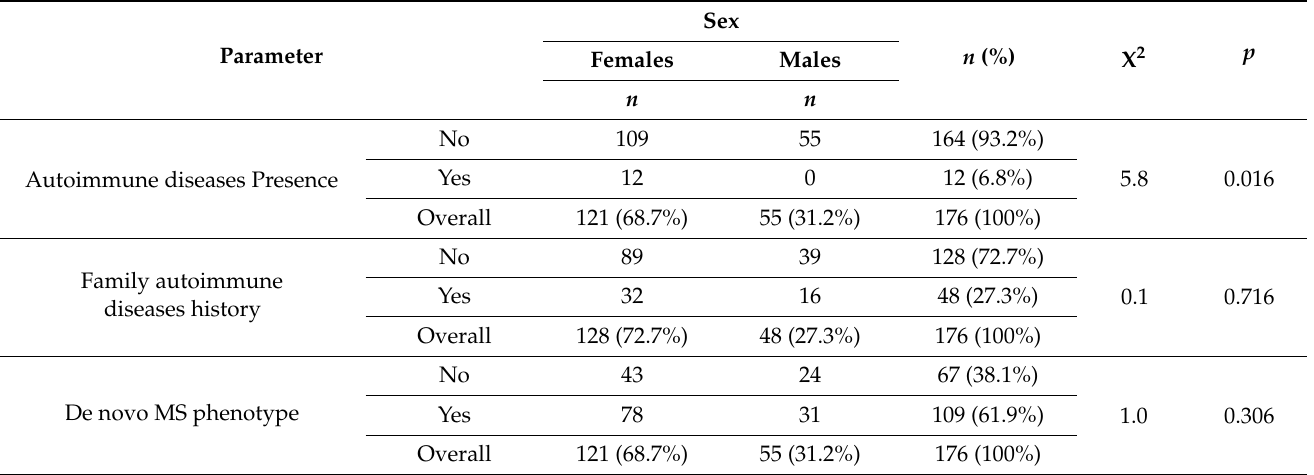
Table 2. Clinical parameters by